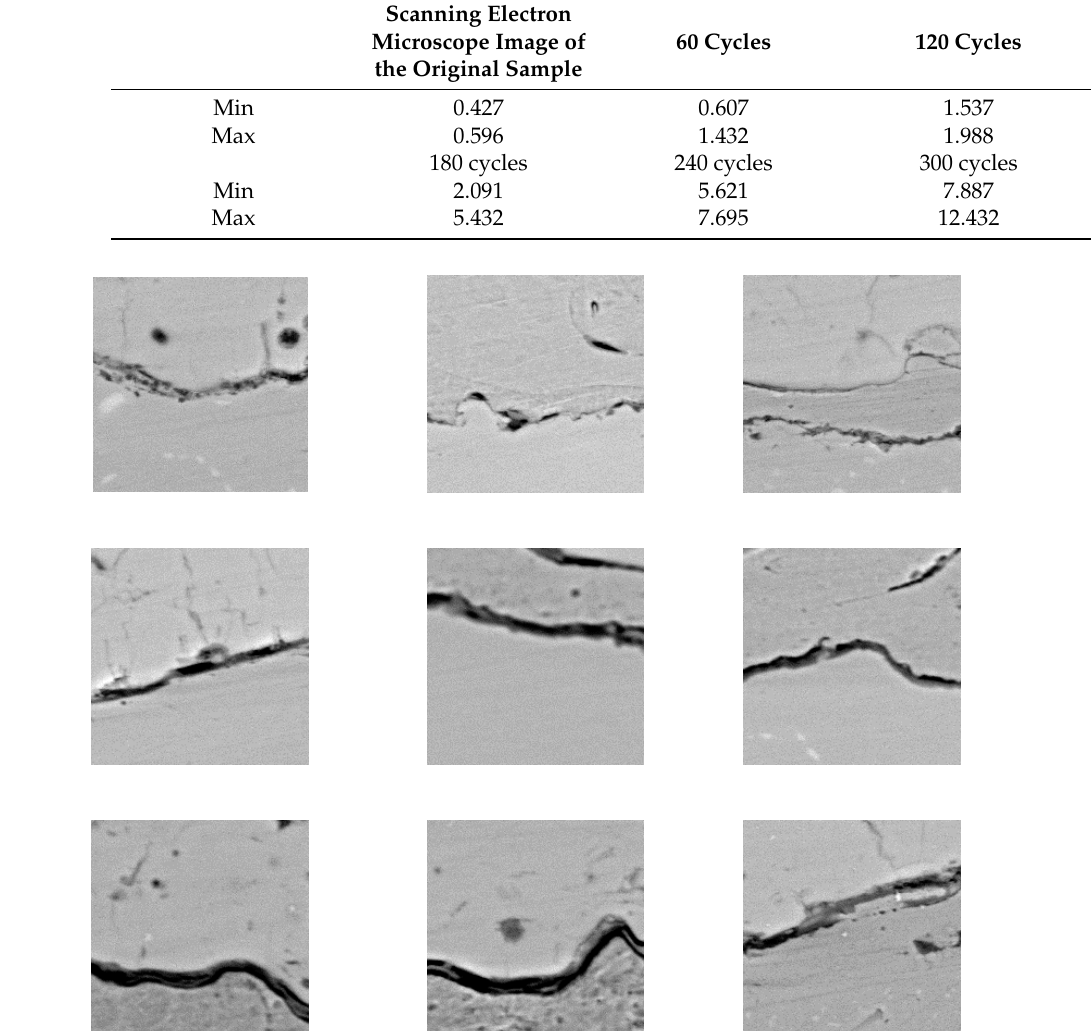
Figure 10. Three random images of each category in TGO dataset. Table 5. Statistical table of test thickness of some samples of SEM with different times of thermal vibration (unit: μ m).